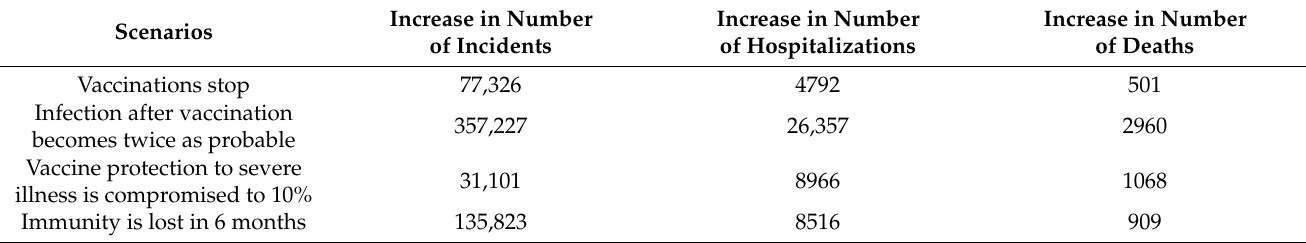
Table 1. Impact of each scenario on the cumulative number of incidents, hospitalizations, and deaths (over the next 90 days after 10 August 2022) relevant to the baseline